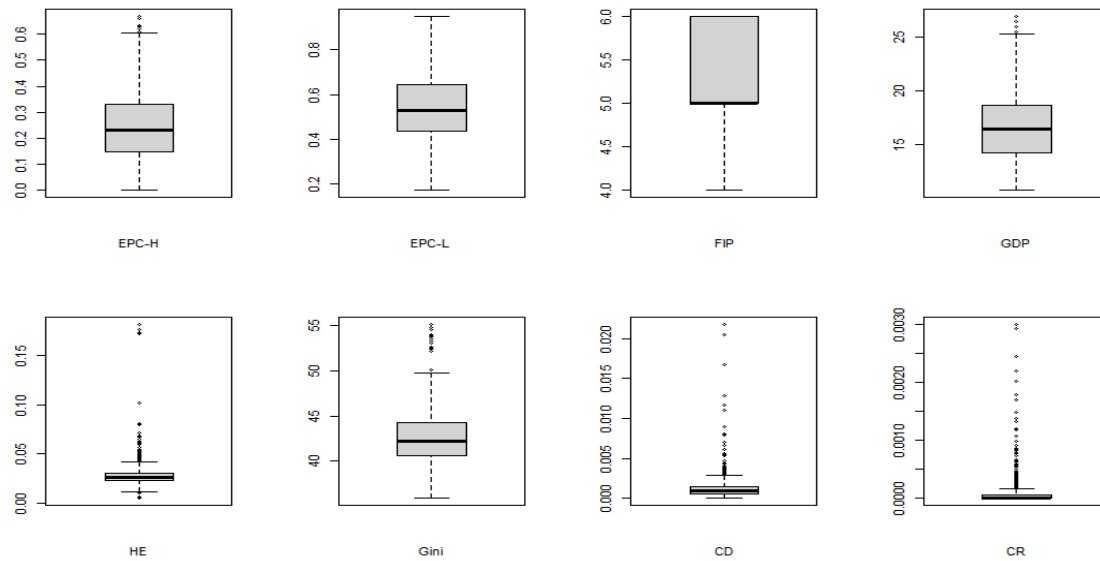
Figure 9. Boxplot for the variables EPC-H, EPC-L, FIP, GDP, HE, Gini, CD, and CR.